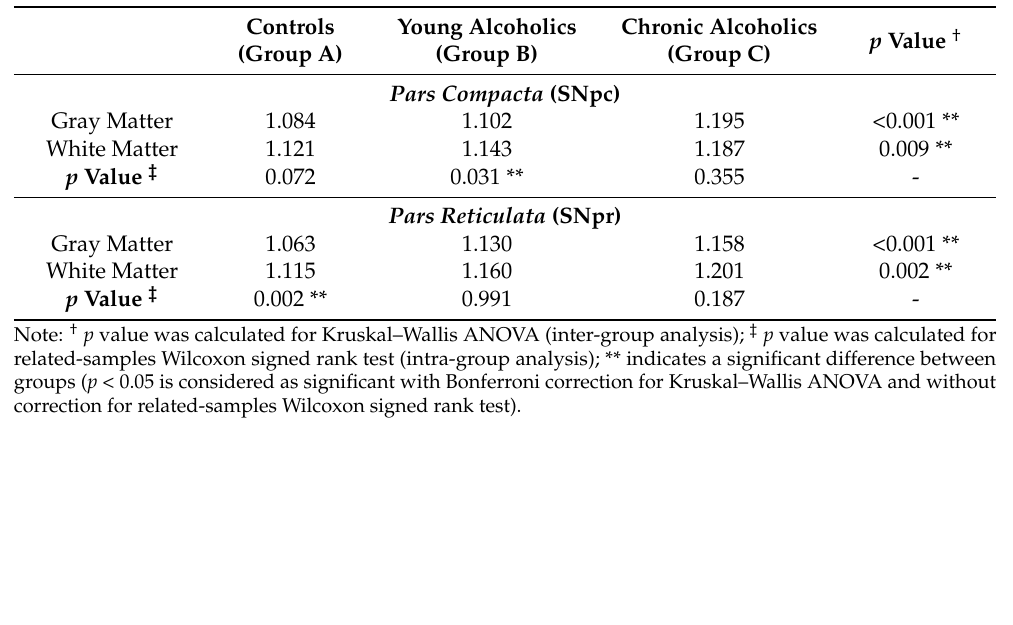
Table 3. Inter-group and intra-group comparisons of the differences in the grades of thickness based on the expression of collagen-IV in the BM of microvessels in the SN region (shown by weighted